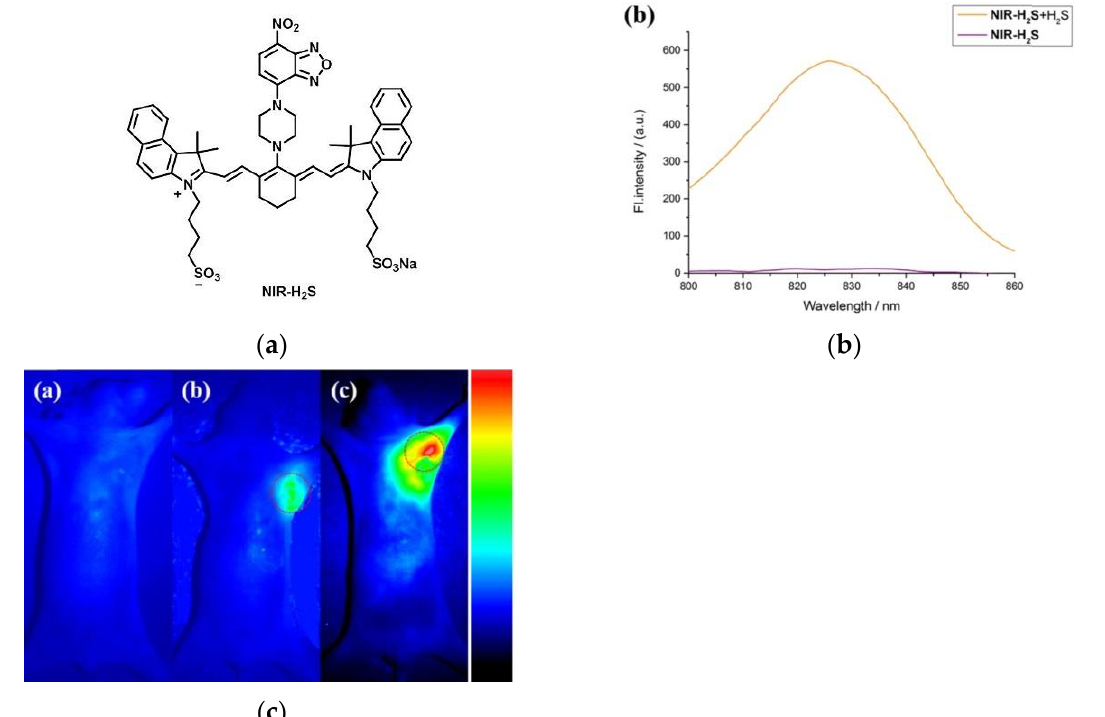
Figure 28. ( a ) Structure of probe NIR-H 2 S; ( b ) Fluorescence spectra of probe NIR-H 2 S; ( c ) Fluorescence images of the tumor-bearing nude mice ( c-a ) The normal, ( c-b ) the HepG2 tumor-bearing and ( c-c ) the MCF-7 tumor-bearing nude mouse was injected with NIR-H 2 S. Reproduced with permission from [121]. Copyright 2018 Elsevier B.V.